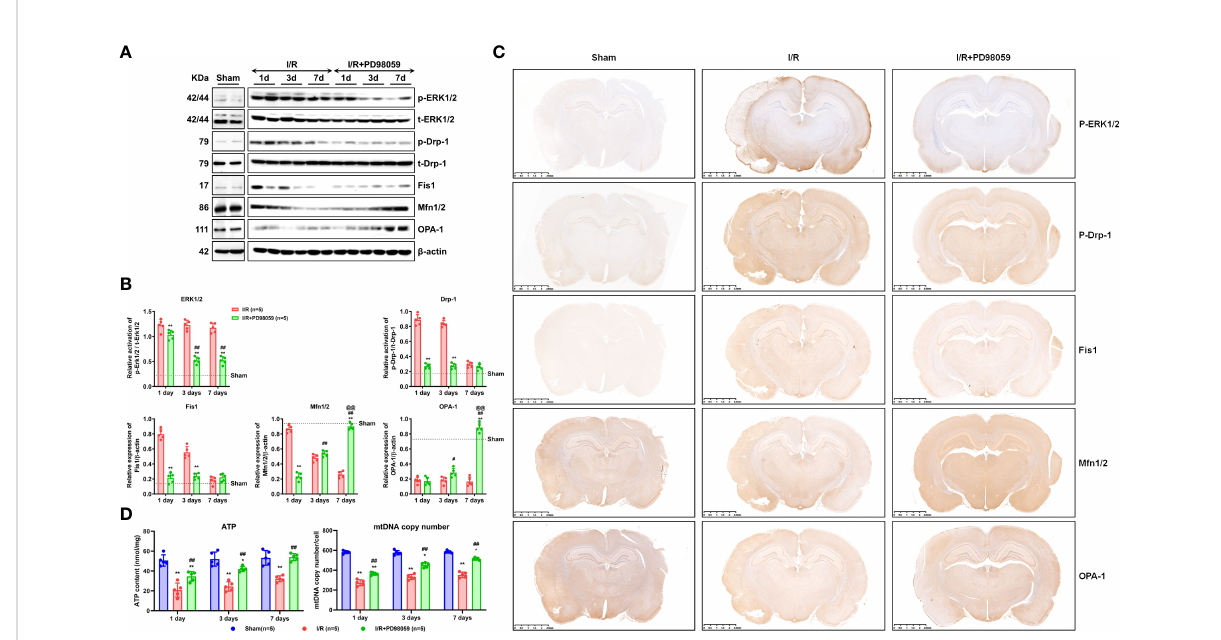
FIGURE 4 ERK1/2 inhibitor modulated mitochondrial balance. After I/R injury and administration of PD98059 in sham and diabetic rats, the phosphorylation level of ERK1/2 and Drp-1, and the expression of Fis1, Mfn1/2, and OPA1 on the 1 st , 3 rd , and 7 th day were detected using western blot (A) , and gray values were determined by ImageJ (B) . The expression of ERK1/2, Drp-1, Fis1, Mfn1/2, and OPA1 was also analyzed via immunohistochemistry (IHC) (C) . The mitochondrial DNA copy number and the ATP content were detected using Mitochondrial DNA copy number and ATP assay kits (D) . In each group, n = 5, all the results are Mean ± SD, compared with I/R, *p < 0.05, **p < 0.01; compared with the group of I/R + PD98059 treated for 1 day, # p < 0.05, ## p < 0.01; compared with the group of I/R + PD98059 treated for 3 days, @@ p <